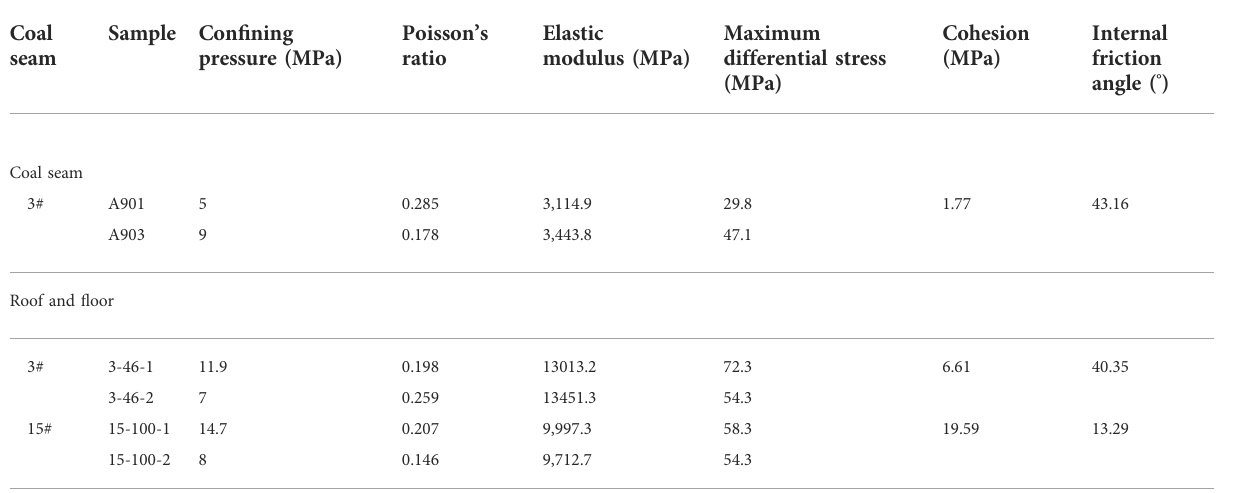
TABLE 4 Mechanical parameters obtained at different con fi ning